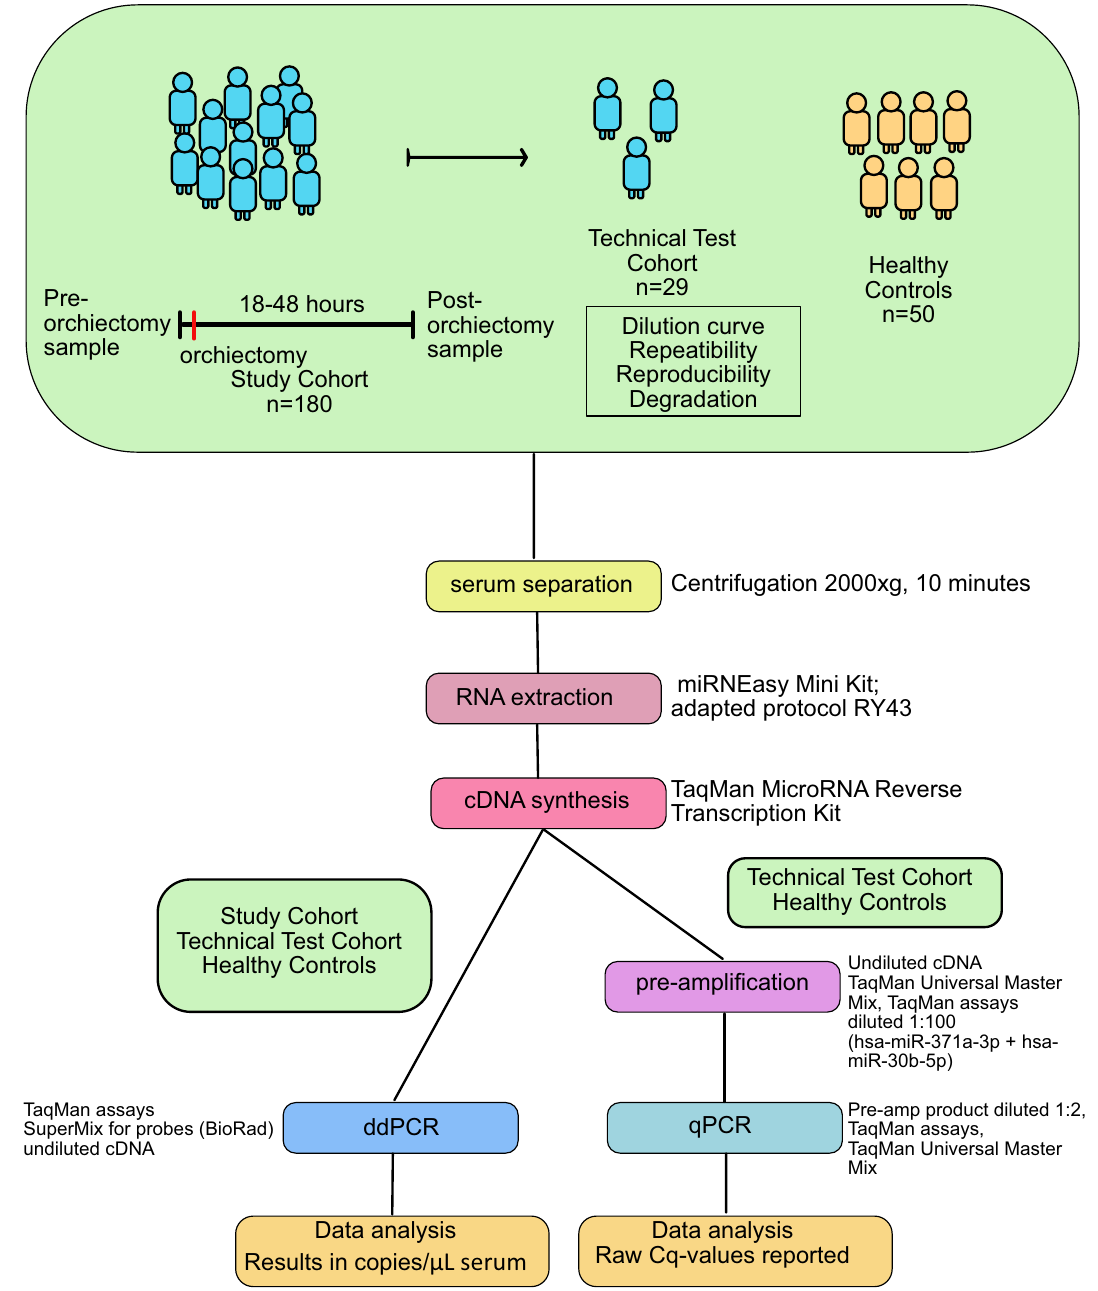
Figure 5. Flow chart summarizing the flow of patients through the study and the laboratory methods used in each